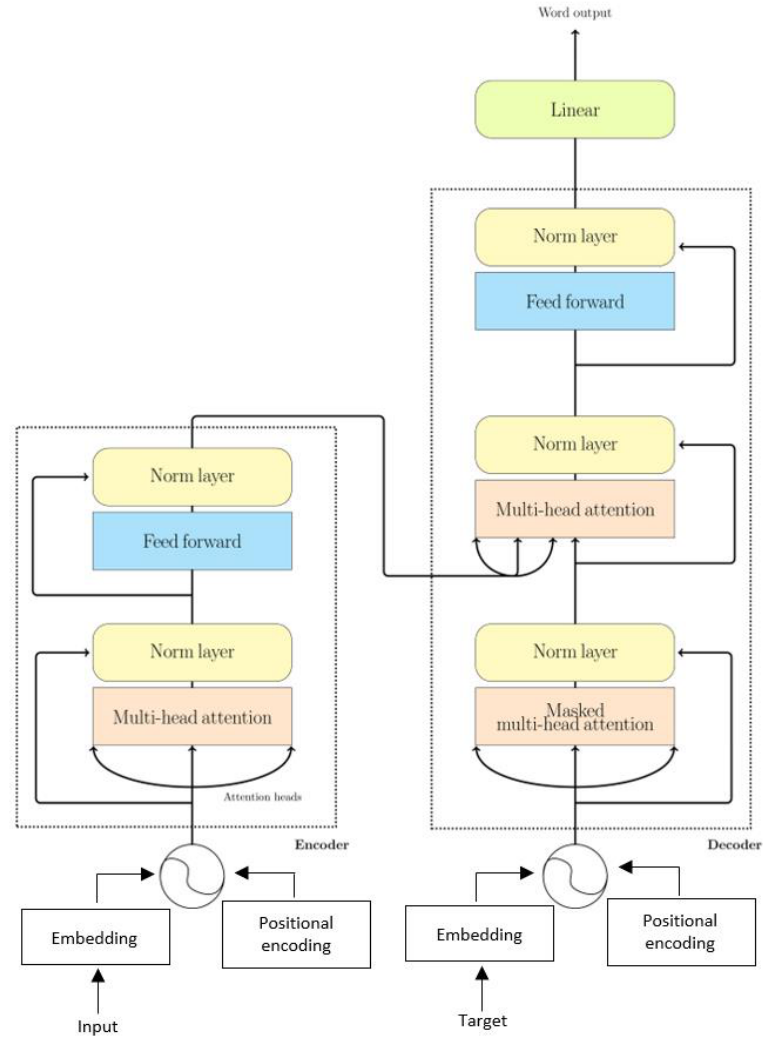
Figure 6. Structure of the Transformer model.